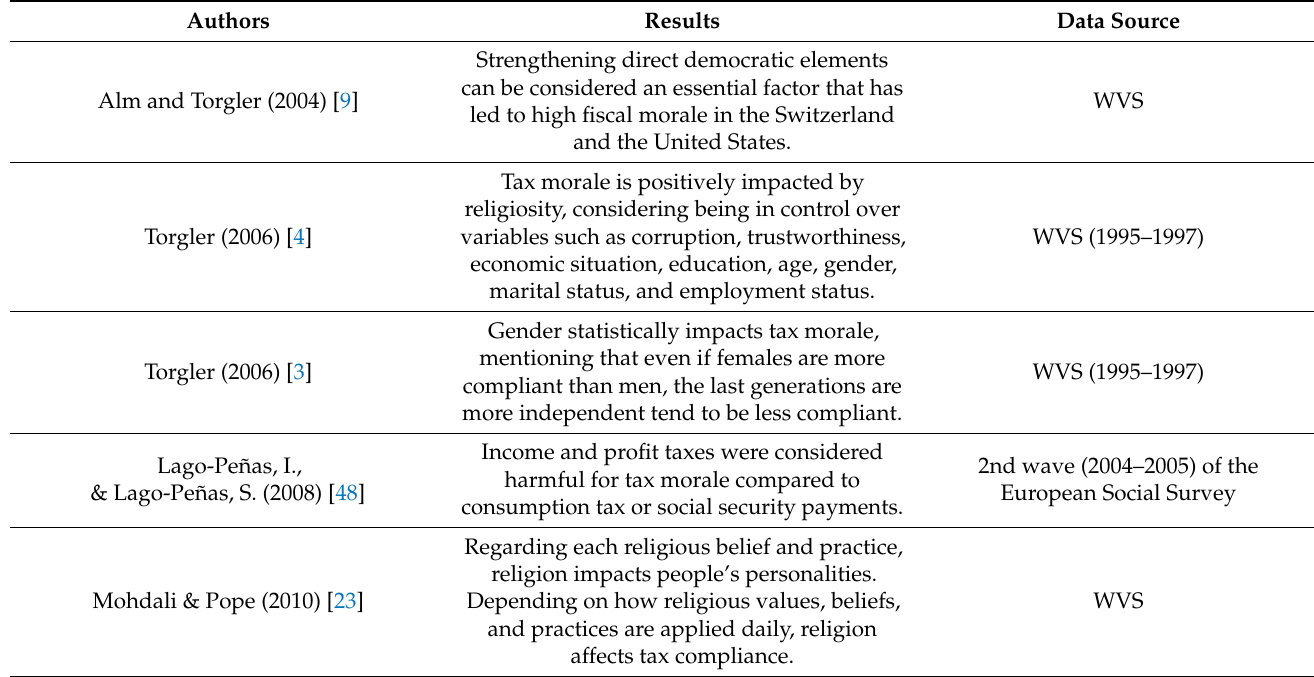
Table 1. An overview of the most relevant empirical studies in the field in the past 20